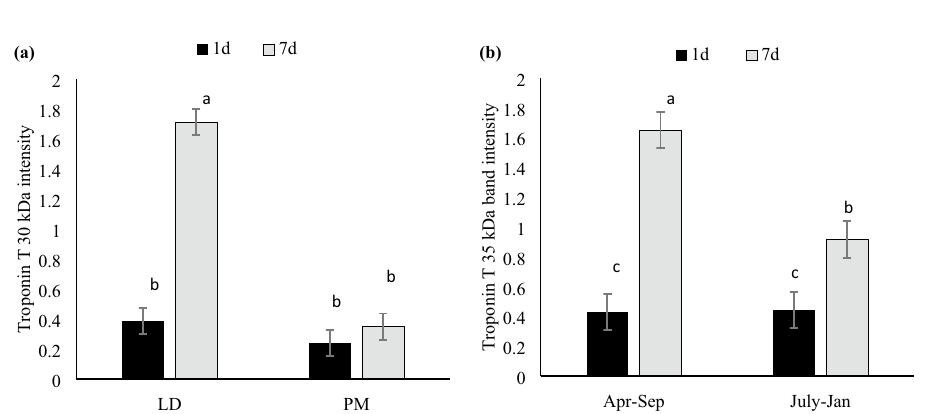
Figure 2. Densitometric analysis of troponin T degradation of porcine LD (longissimus dorsi) and PM (psoas major) muscles with two production replicates. A. Muscle by aging interaction (P = 0.02) on troponin T degradation product intensity at 30 kDa; B. Replicate by aging interaction tendency (P = 0.054) on troponin T degradation product intensity at 35 kDa; Results were displayed as means ± standard error. (a–c) Means with different number are significantly different (P < 0.05). July–Jan: Pigs weaned in July 2016 and harvested in January 2017; Apr–Sep: Pigs weaned in April 2017 and harvested in September